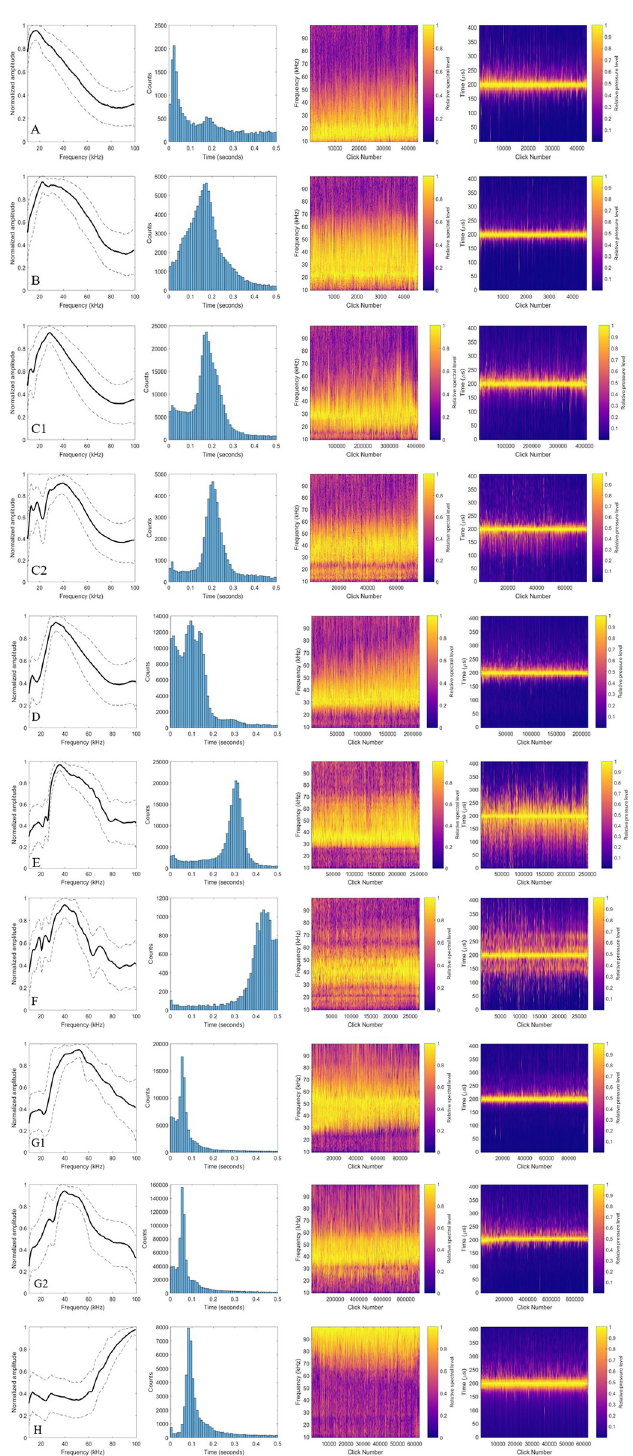
Fig 2. Echolocation click types. Plots A-H depicting data from representative clicks from each of 10 final click types: (A) False killer whale, (B) Low-frequency type 1 (LF1), (C1) Short-finned pilot whale 1, (C2) Short-finned pilot whale 2, (D) Bottlenose dolphin/ melon-headed whale, (E) Blainville’s beaked whale, (F) Cuvier’s beaked whale, (G1) Stenellid 1, (G2) Stenellid 2, and (H) Kogia spp. Panels 1–4 (left to right) depict the following: (1) mean spectra, shown along with 10 th and 90 th percentile values, (2) modal inter-click interval distribution, (3) concatenated click spectra of